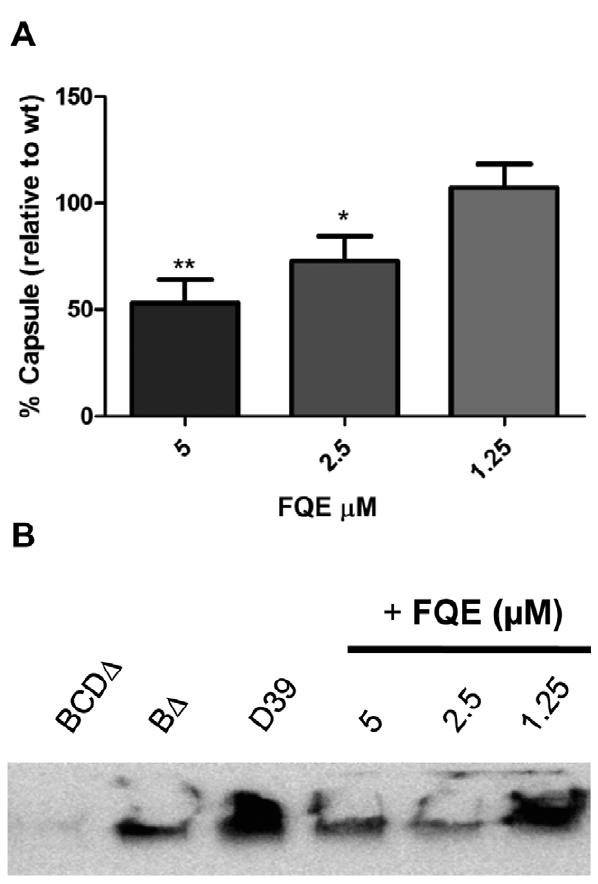
Figure 4. FQE decreases capsule synthesis in S. pneumoniae D39. Total CPS preparations were isolated from equal numbers of bacteria after incubation with FQE for 1 h. CPS levels were analysed by either (A) uronic acid assay or alternatively (B) by separating CPS on SDS-PAGE, transferring to Nylon and the probing with a -cps2 as described in the materials and methods. Data in (A) is from $ 3 independent experiments (5 m M vs 1.25 m M; * - P , 0.05 by Student’s t -